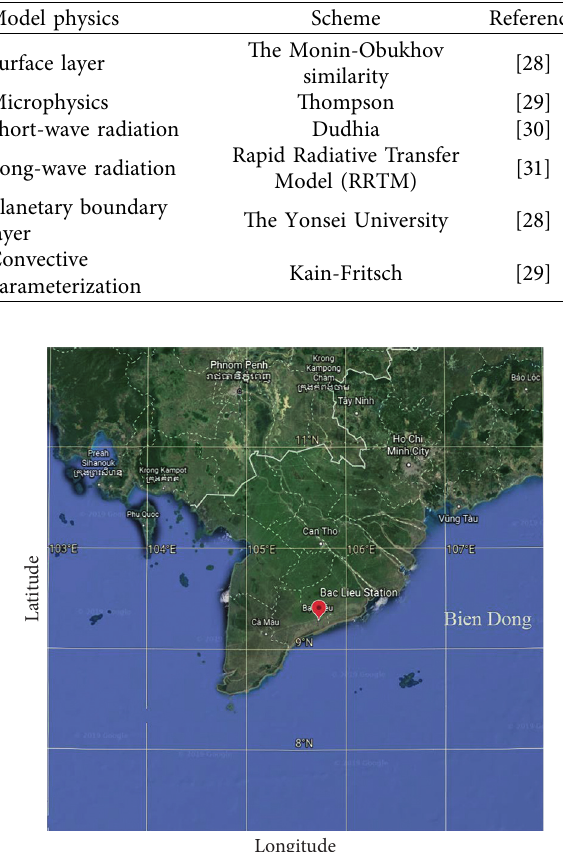
Figure 1: The four nested domains employed in this work with horizontal resolution of 54km (d01), 18km (d02), 6km (d03), and 2km (d04), respectively. Table 1: Physic configurations for simulation in WRF.